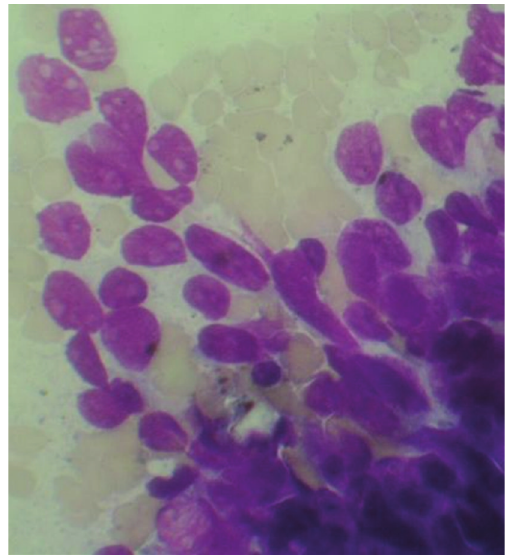
Figure 2: FNAC from the lesion in Case 1 showing the small round blue cells ( × 400 magnification).